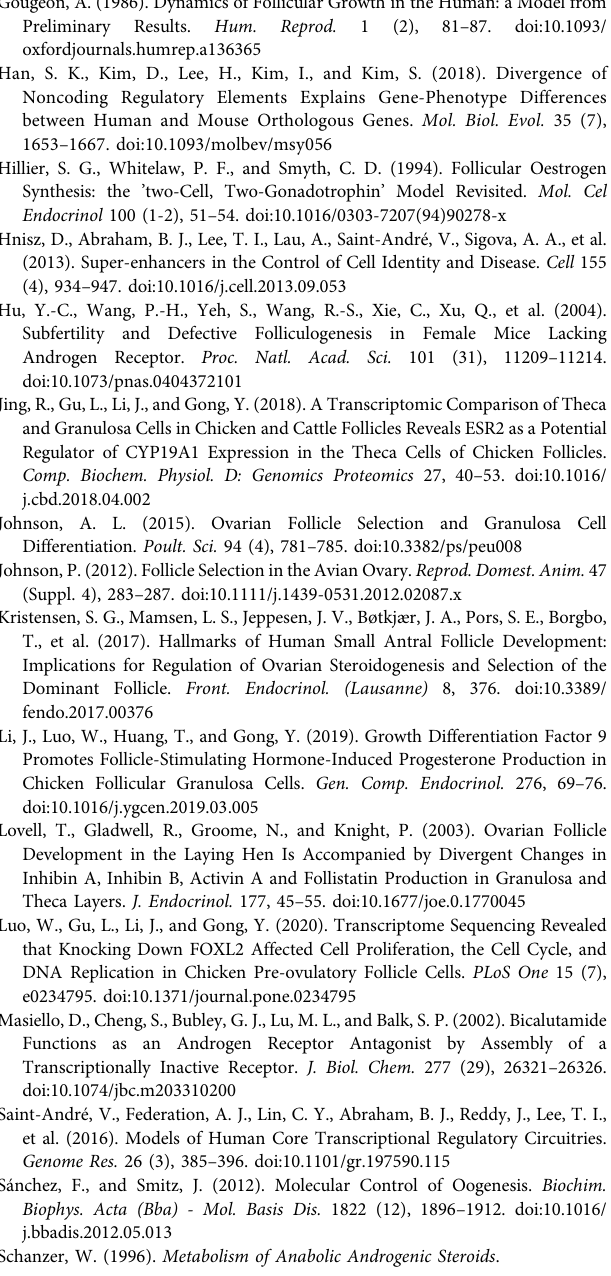
Supplementary Table S4 | Follicle development related BPs among species.xlsx. Supplementary Table S5 | SEGs of GCs or ovary among species.xlsx. Supplementary Table S6 | Egg production records.xlsx. Supplementary Table S7 | Follicle Count